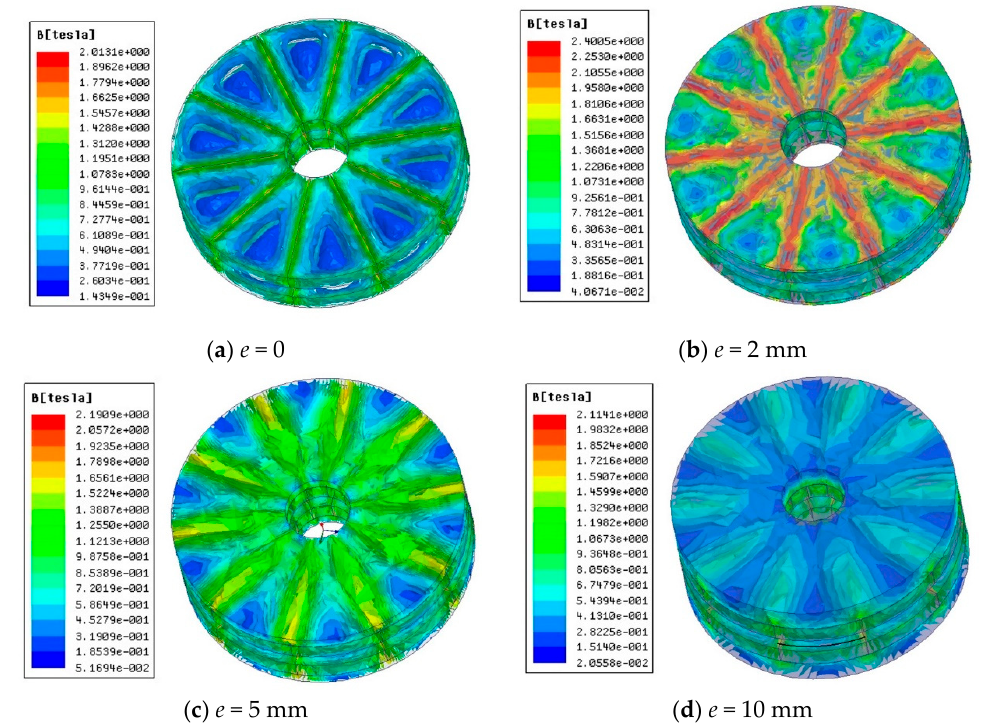
Figure 11. The magnetic flux density distribution of magnetic couplings with different iron yoke thickness.